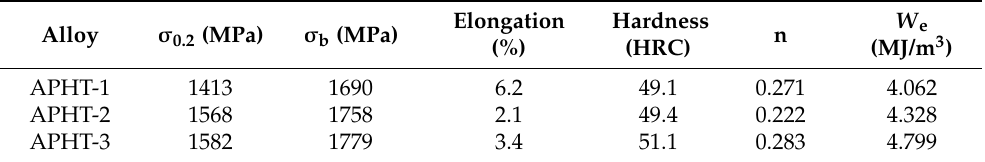
Figure 6. Mechanical property curves of all specimens at room temperature: ( a ) engineering stress – strain curves; ( b ) variation curves in ln S with ln e for three samples; ( c ) diagram of elastic energy; ( d ) impact energy of samples. Table 2. Mechanical property data of the ultrahigh strength steels.